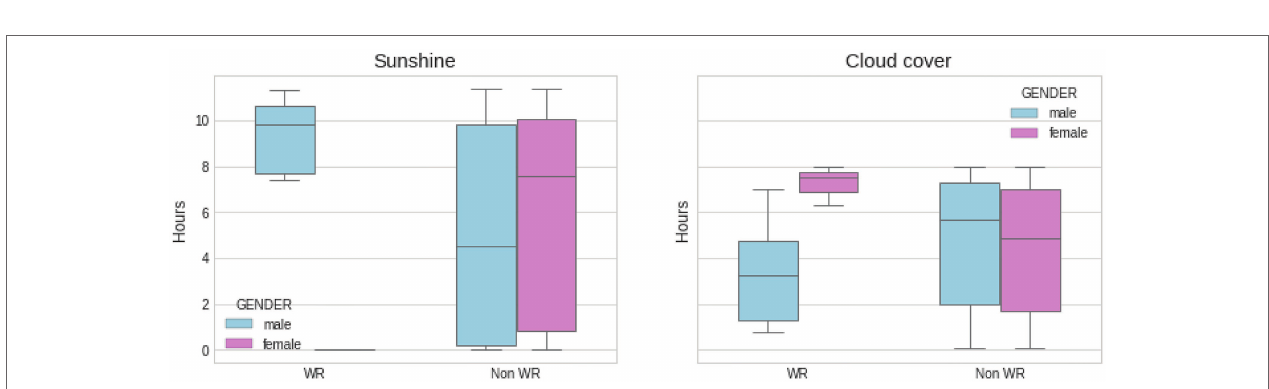
FIGURE 3 | Comparative analysis of weather conditions [temperature ( ° Celsius), atmospheric pressure (mbar), and precipitation (mm)] on WR marathon performances and elite marathon performances (winner, top three, and top 10) by gender, with SD. Around 95% CI was used to create the boxplots. Statistical difference between WR female performance and precipitation to other performance groups ( p < 0.05).